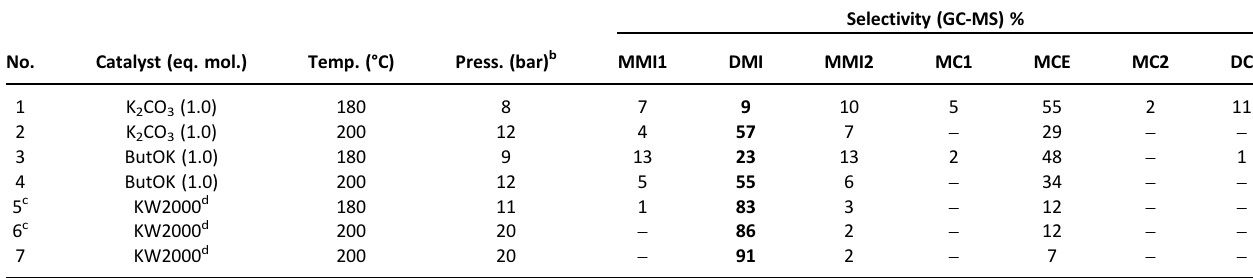
Table 5. Methylation reaction of isosorbide in autoclave using different bases/catalysts. a